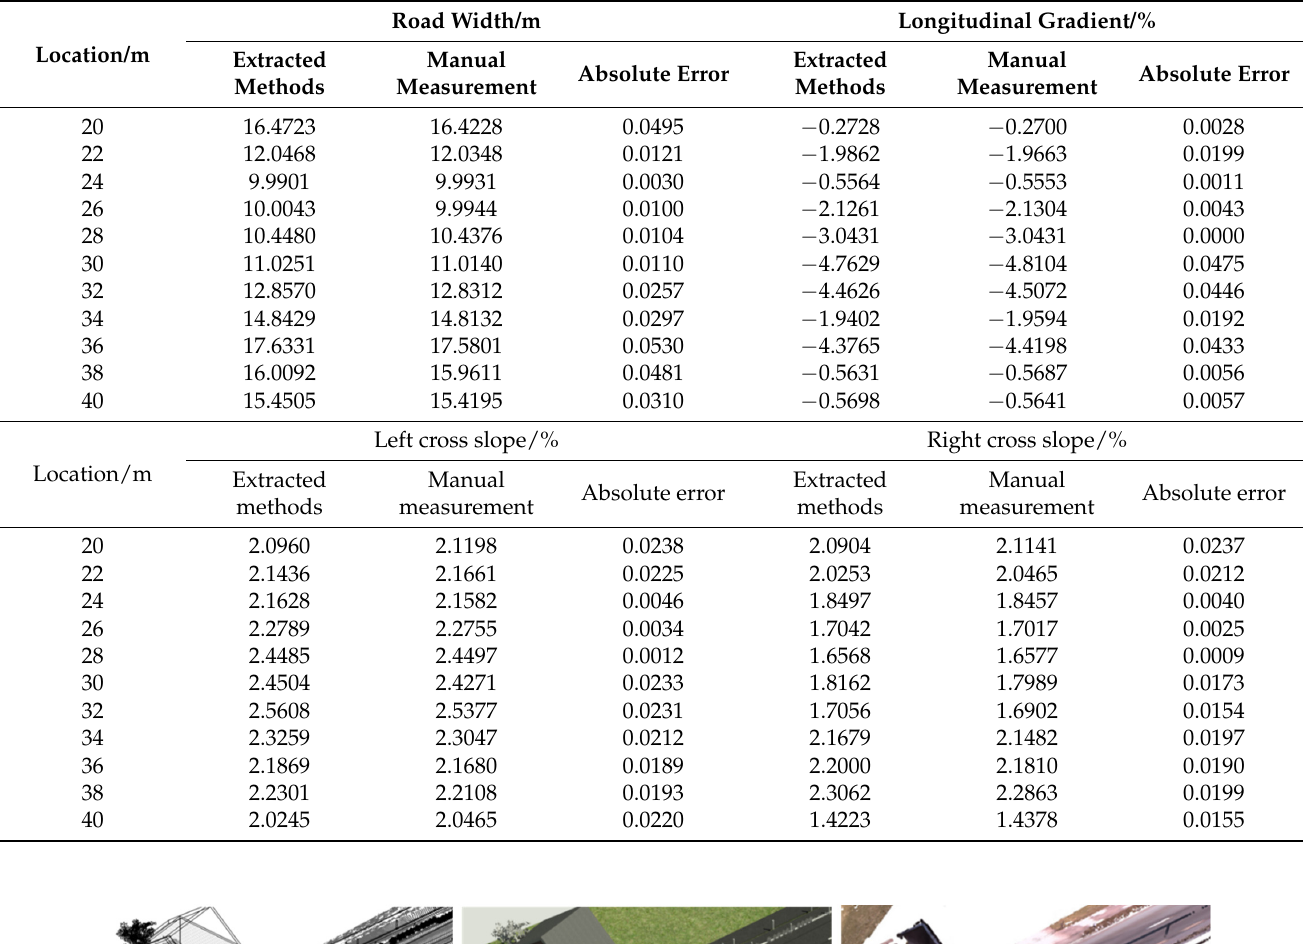
Table 4. Comparison between extracted and manually measured geometric information.